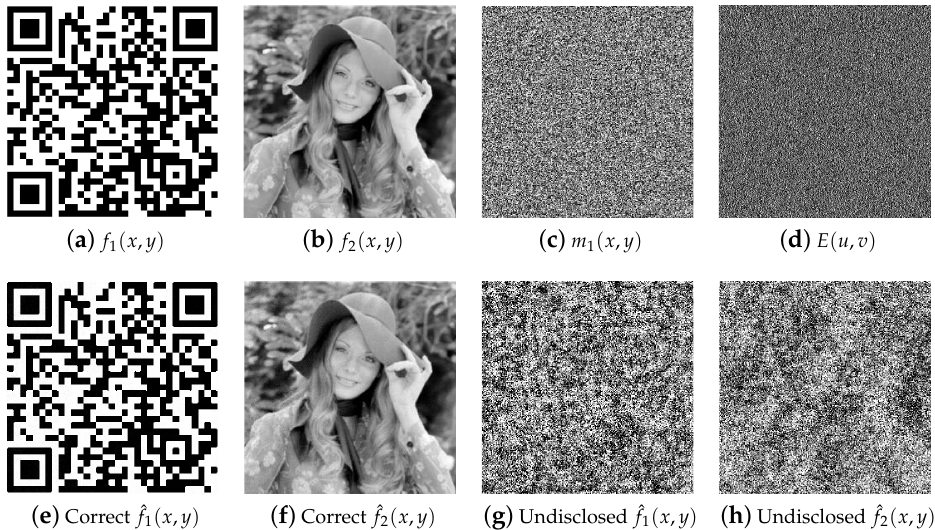
Figure 2. ( a , b ) Original images to be encrypted f 1 ( x , y ) and f 2 ( x , y ) , respectively; ( c ) image of the random distribution m 1 ( x , y ) of the RPM r 1 ( x , y ) ; ( d ) encrypted image E ( u , v ) ; ( e , f ) correct decrypted images ˆ f 1 ( x , y ) and ˆ f 2 ( x , y ) , respectively, using the right four security RPMs; ( g , h ) wrong decrypted images ˆ f 1 ( x , y ) and ˆ f 2 ( x , y ) , respectively, when the incorrect security key RPM h 1 ( x , y ) and the other three correct security keys RPMs are used in the decryption